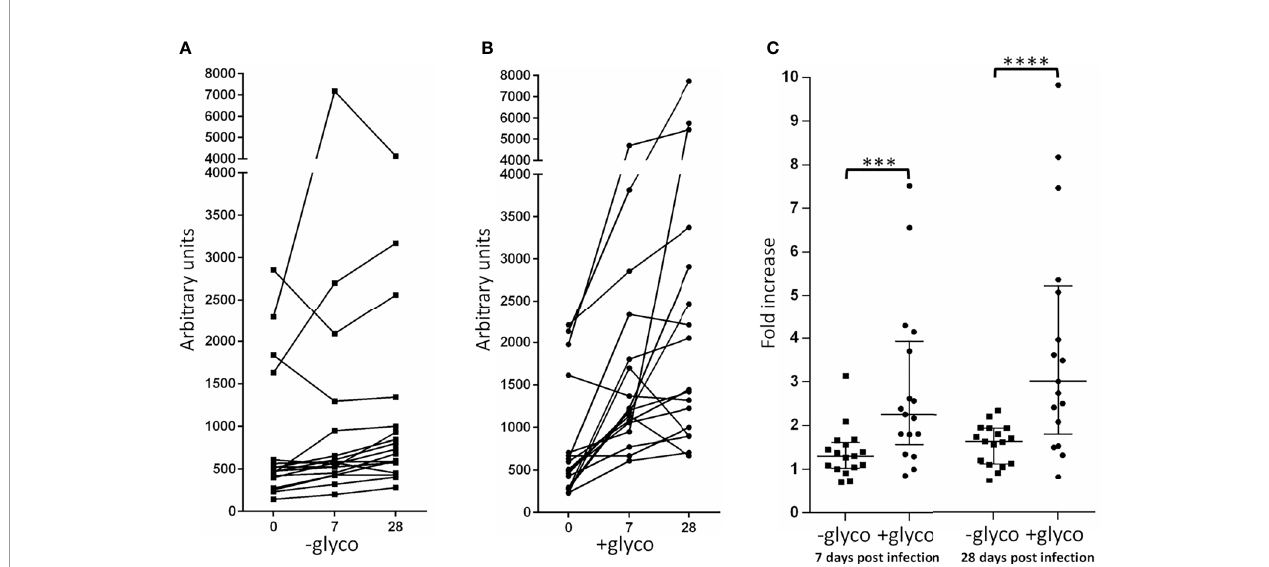
FIGURE 2 | ELISA experiment using 17 serum samples from a controlled human infection model (CHIM) study showing the relative immune response towards glycosylated YghJ (+glyco) and the non-glycosylated protein variant (-glyco). (A) Arbitrary anti non-glycosylated YghJ IgG/A/M antibody levels in serum 0, 7 and 28 days after ETEC ingestion is shown. (B) Arbitrary anti glycosylated YghJ IgG/A/M antibody levels in serum 0, 7 and 28 days after ETEC ingestion is shown. (C) The ratio between measured endpoint titers obtained at Day 0 and Day 7 as well as Day 0 and Day 28 for antibodies that bound – glyco (squares) or +glyco (circles) was calculated and plotted. A Wilcoxon matched-pairs signed rank test was performed to evaluate signi fi cant differences in the immune response towards glycosylated and non-glycosylated YghJ. ***P = 0.0003. ****P < 0.0001. Median with interquartile range for each data set is